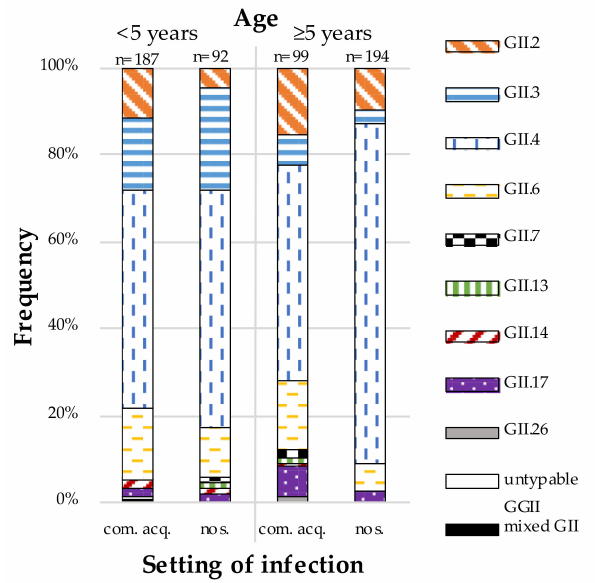
Figure 2. Distribution of GII norovirus genotypes according to age and mode of acquisition, Leipzig University Hospital October 2013–September 2017; com. acq. stands for community-acquired infections and nos. stands for nosocomial infections.